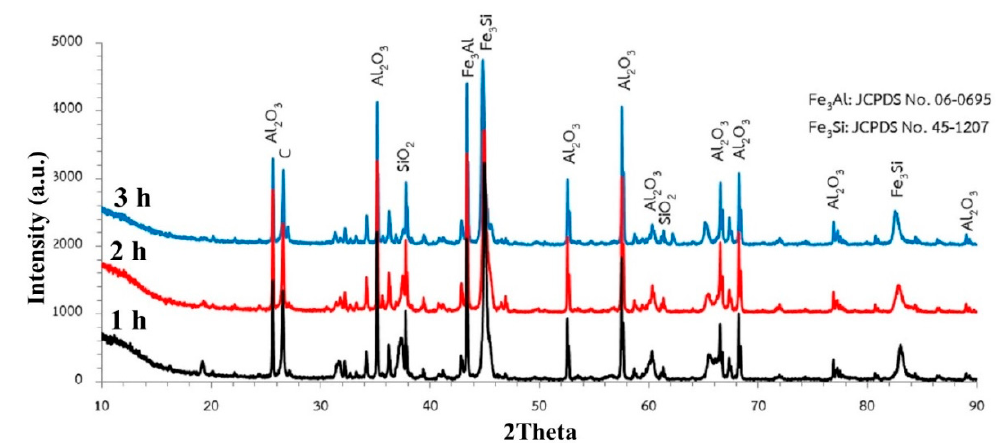
Figure 6. XRD patterns of the pellet (C/O = 2) after heating at 1550 °C for up to 3 h. The formation of Fe 3 Al and Fe 3 Si can be explained via the carbothermic reduction reaction of Fe 2 O 3 , Al 2 O 3 , and SiO 2 at 1550 °C under an argon atmosphere. The reduction of Fe 2 O 3 by solid carbon atom can occurred via Equations (1)–(3), and produce liquid Fe and CO into the system [32,33]. The produced CO could possibly react with Fe 2 O 3 as a reducing agent and produce liquid Fe and CO 2 into the system, as shown in Equations (4)–(6) [32,33]. At 1550 °C, standard Gibbs free energy ( Δ G°) for Equations (3) and (6) is − 124.46 kJ and − 272.71 kJ, respectively.